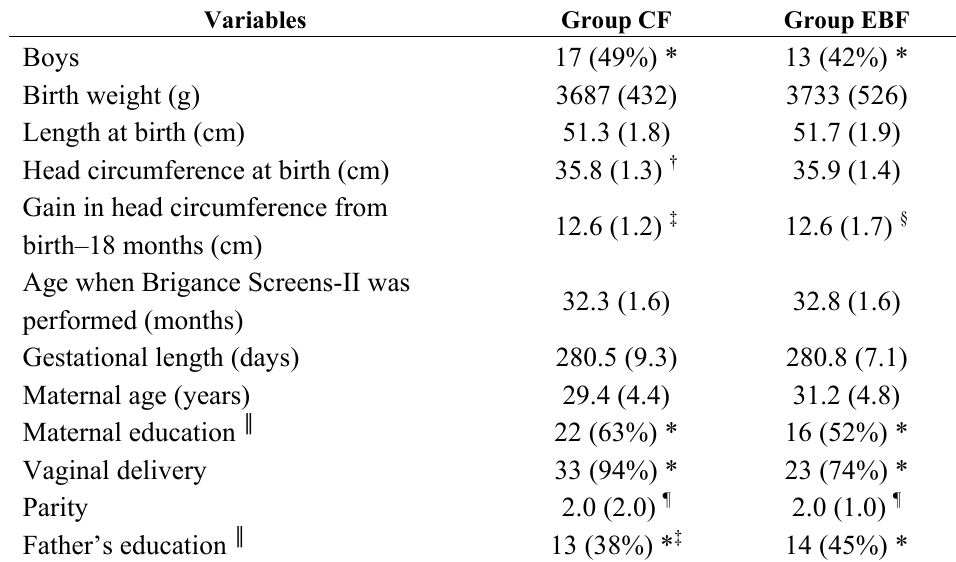
Table 1. Baseline characteristics of participants with scores from Brigance Screens-II at 30–35 months of age in the two study groups: infants who received complementary foods in addition to breast milk from 4 months (CF, n = 35) compared with infants who were exclusively breastfed for 6 months (EBF, n =